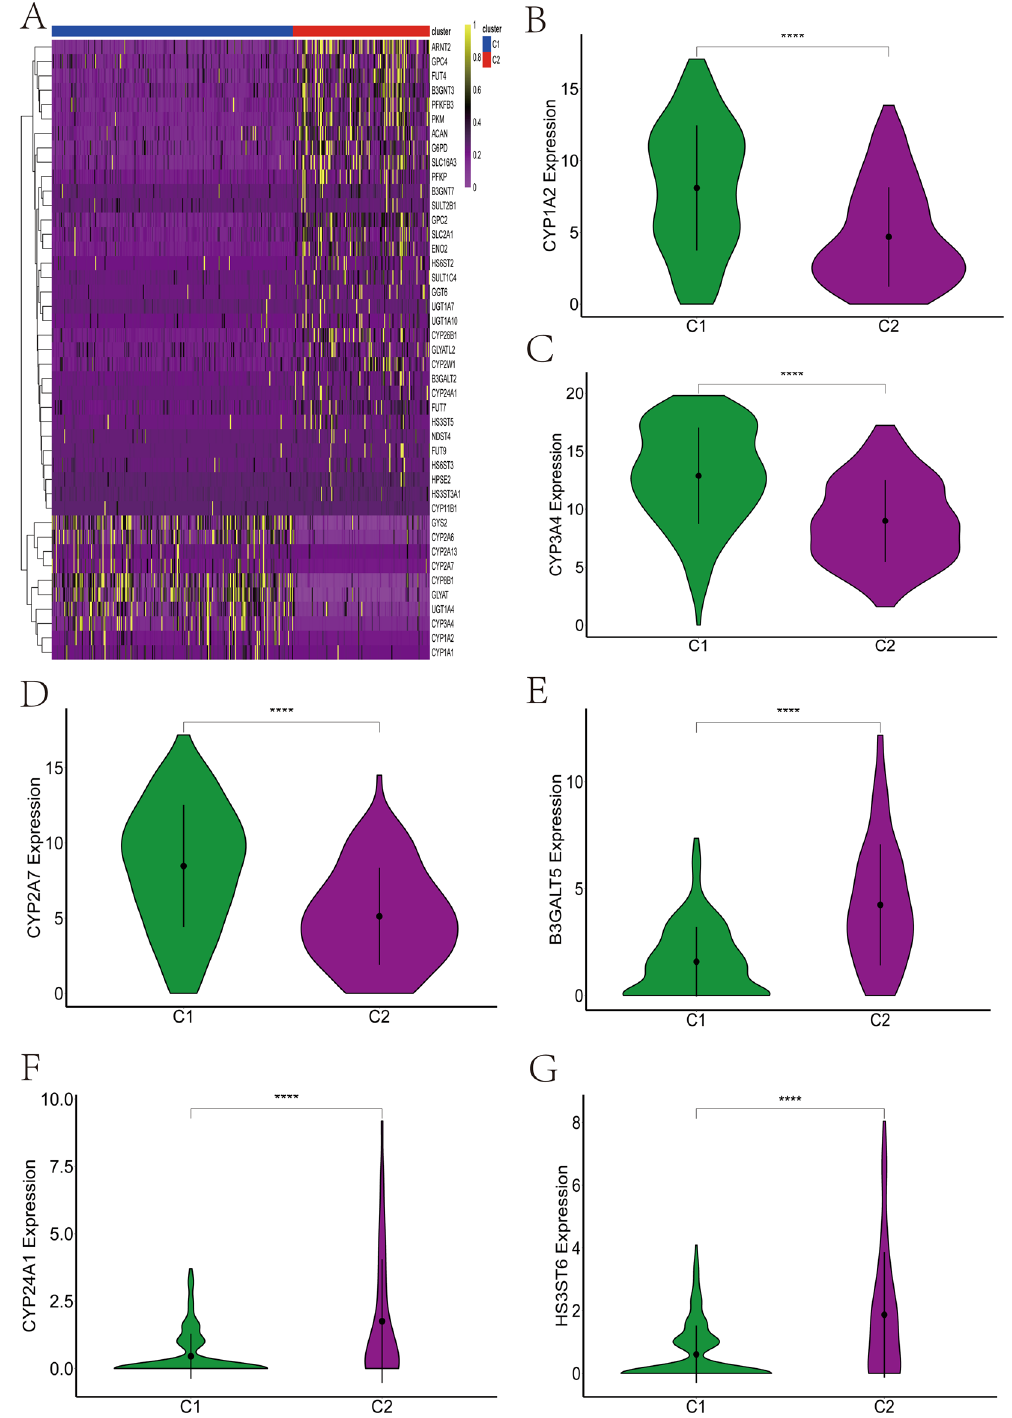
Figure 3. The expression levels of genes related to energy metabolism differed significantly between clusters. ( A ) Heatmap results showed that most energy metabolism-related genes were highly expressed in C2. ( B – D ) Energy metabolism-related genes such as CYP1A2 ( B ), CYP3A4 ( C ), CYP2A7 ( D ) were overexpressed in C1 compared to C2. ( E – G ) Energy metabolism related genes such as B3GALT5 ( E ), CYP24A1 ( F ), HS3ST6 ( G ) were highly expressed in C2 compared to